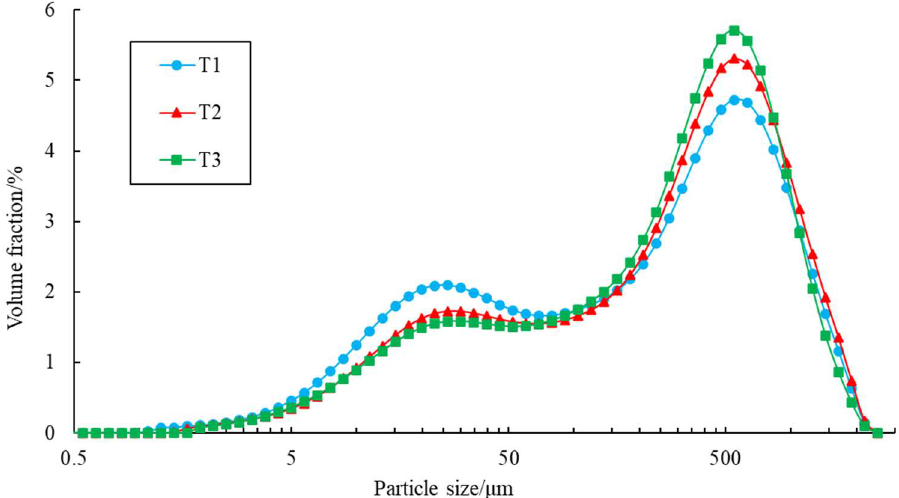
Figure 6. Particle size distribution of a peanut whole-feed harvester under different air volumes.